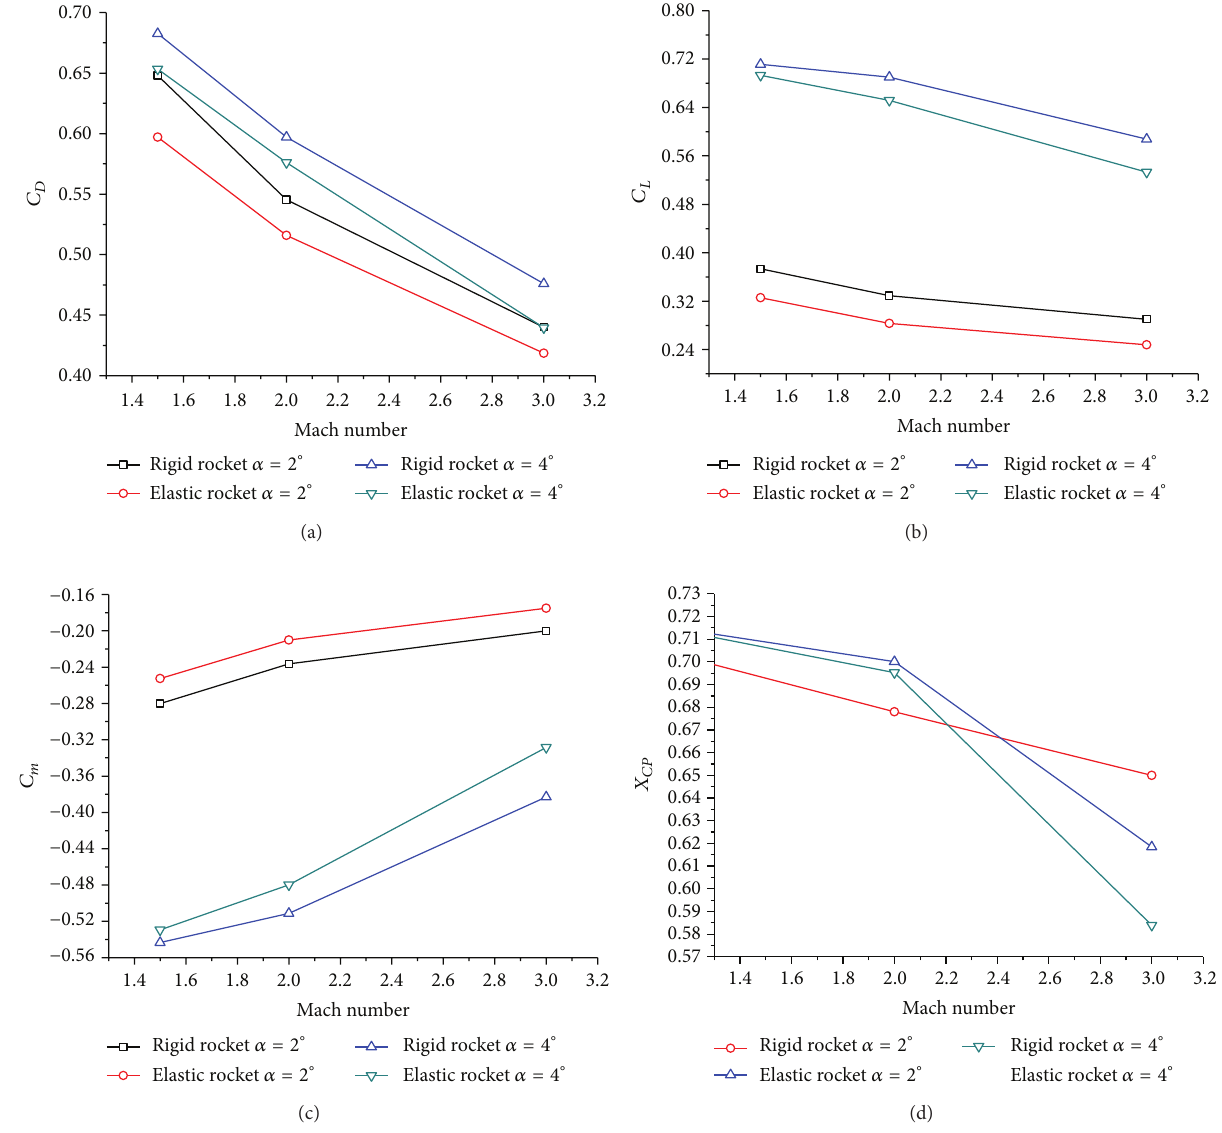
Figure 9: Aerodynamics coefficients versus Mach number (Ma) for elastic and rigid rocket: (a) 𝐶 𝐷 , (b) 𝐶 𝐿 , (c) 𝐶 𝑚 , and (d) 𝑋 𝑐𝑝 .